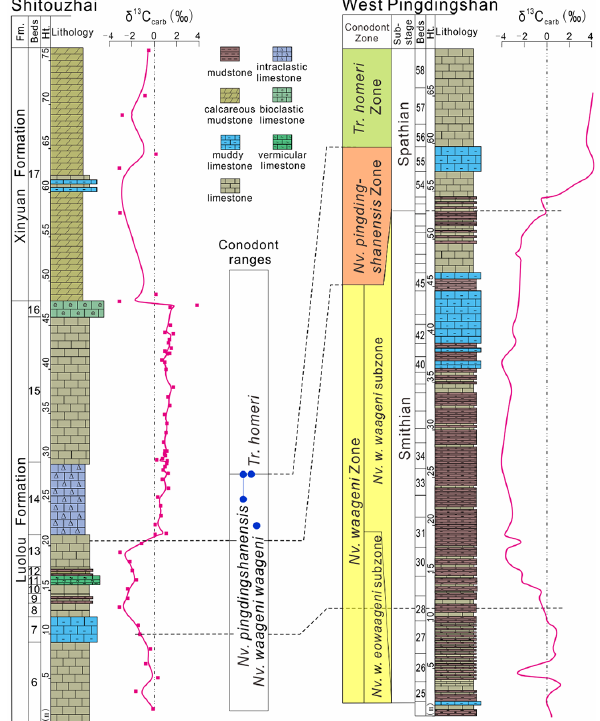
Figure 1. Correlation of the Shitouzhai section in southern Guizhou Province with the West Pingdingshan section in Chaohu, Anhui Province, South China. Sources of West Pingdingshan data: con- odont zonation (Zhao et al., 2007) and C-isotope curve (Tong et al., 2007). Correlations between these sections are based primarily on corresponding features in the C-isotope profiles, although limited new conodont data for Shitouzhai (central column; n = 4) provide additional constraints. Fm. and Ht. stand for formation and height,